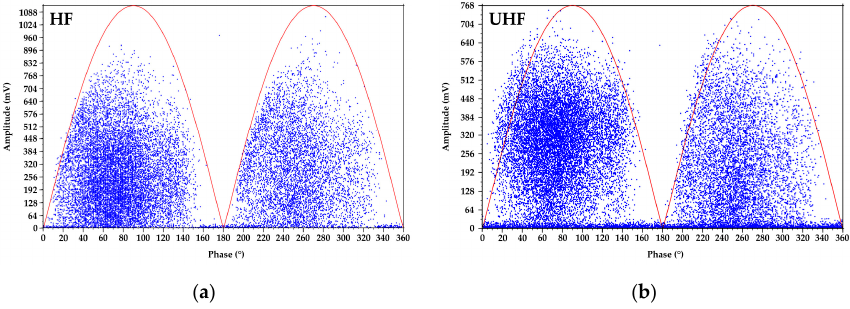
Figure 25. PRPD patterns obtained in a monitoring system for partial discharges pulses registered in a measurement channel: ( a ) of high frequency, ( b ) of ultra-high frequency. measurement channel: ( a ) of high frequency, ( b ) of ultra-high